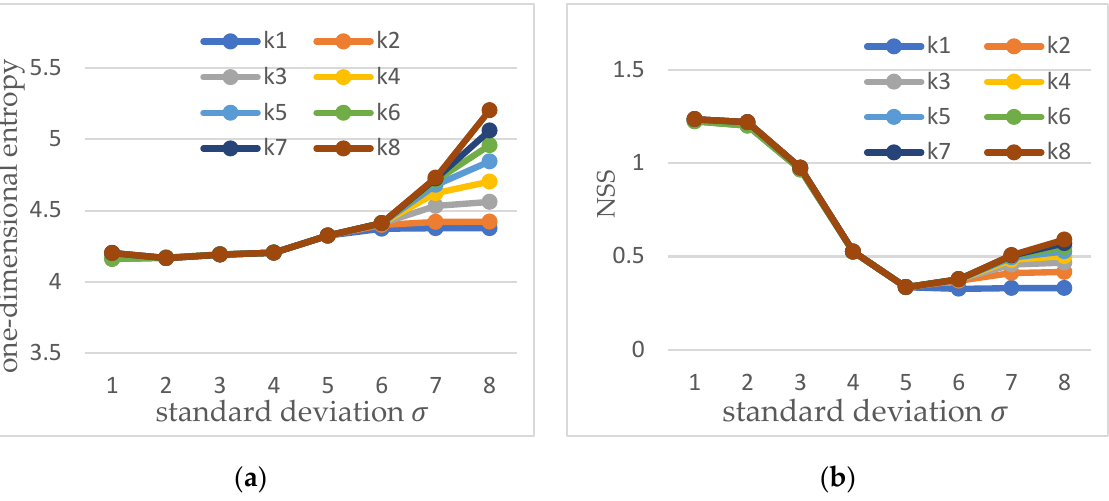
Figure 2. ( a ) Entropy value obtained by Gaussian parameter template, ( b ) saliency evaluation result. The horizontal axes in Figure 2 represent the parameters of the standard deviation of different Gaussian templates. The vertical axis in Figure 2a is the one-dimensional